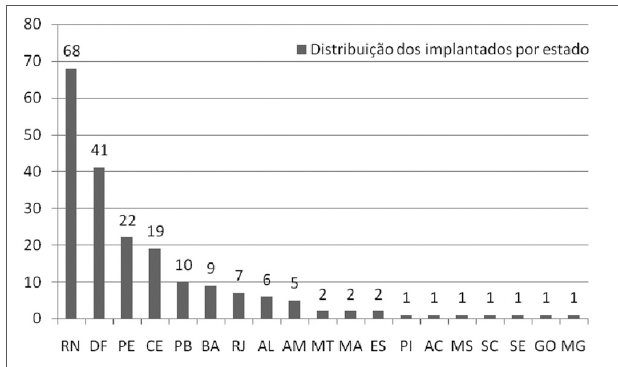
Figura 3. Distribuição dos pacientes implantados de acordo com o estado de